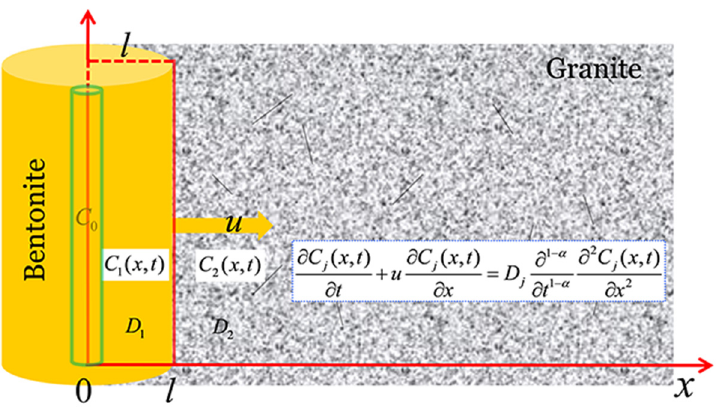
Figure 1. Deep geological disposal concept of the HLW repository.